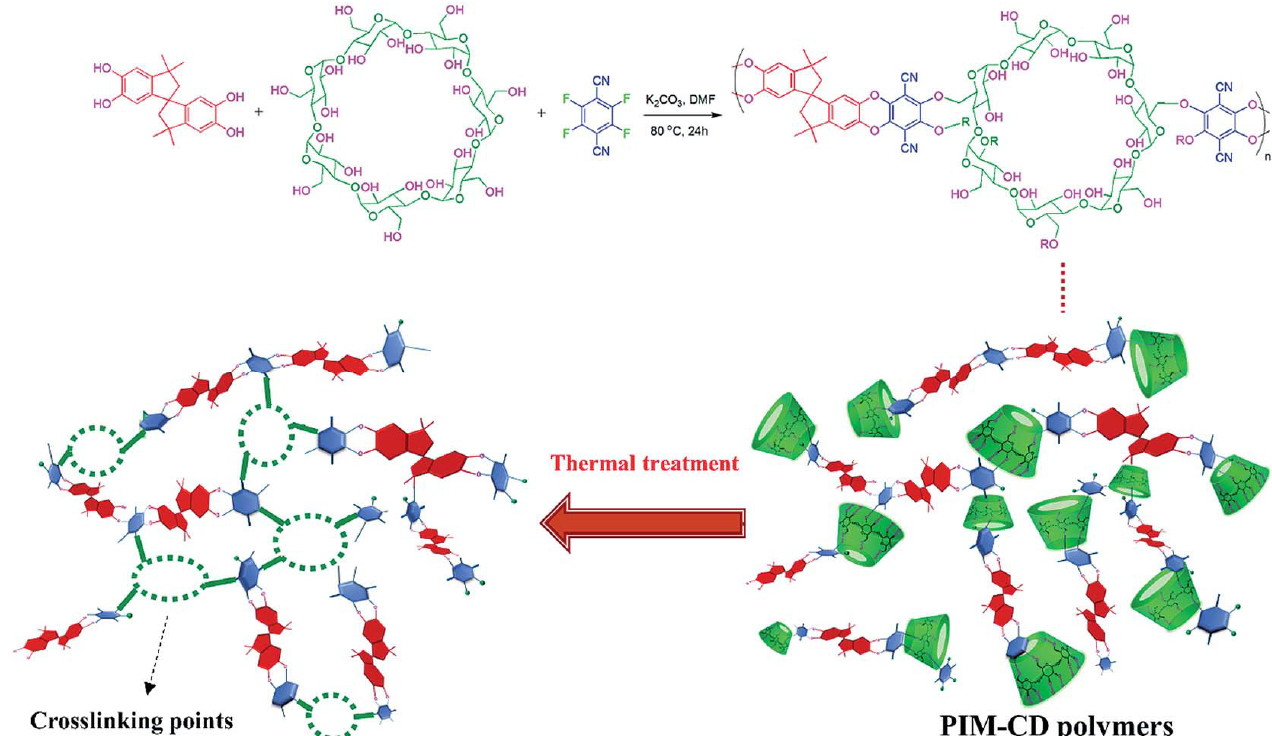
Figure 13. Synthesis and thermal crosslinking of a PIM-CD polymer precursor. Adapted from [122] with permission. Copyright (2017) Royal Society of Chemistry.